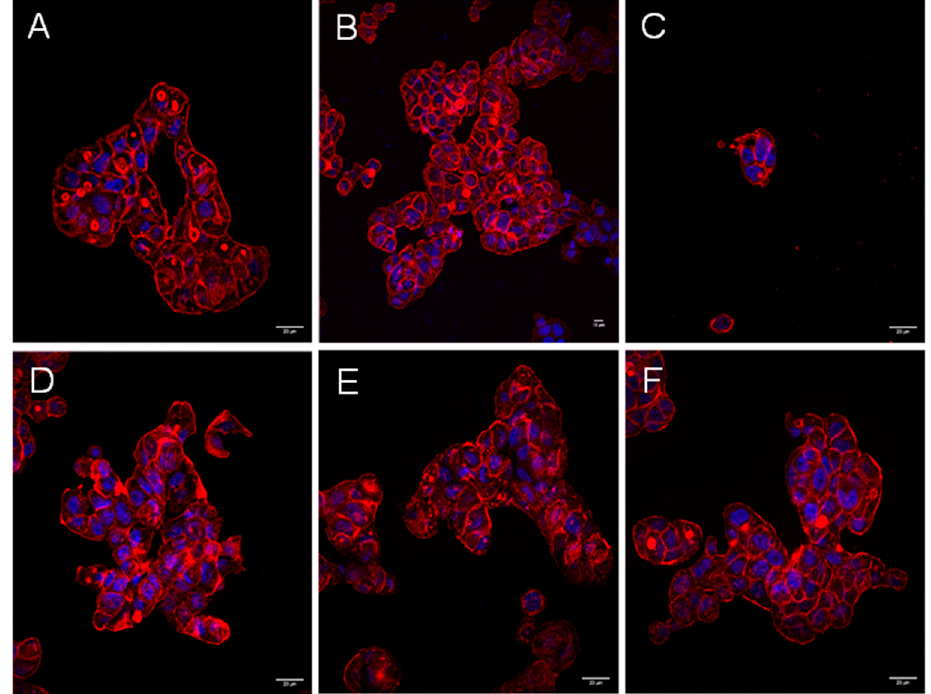
Figure 1. Aeromonas strains trigger a cytotoxic effect during the infection of HT-29 cells, but not the extracellular products they generate during their growth in the presence or absence of eukaryotic cells. Infection was carried out with non-cytotoxic strains LE20E ( A ), CI20E ( B ), and cytotoxic strain AG29E1 ( C ) for 90 and 180 min. Cells were fixed and stained for immunofluorescence. ( D – F ) Co-culture of Aeromonas strains (non-cytotoxic strain LE20E, cytotoxic strains CI21E, and AG29E1, respectively) with HT-29 cells in the inserts system. The actin cytoskeleton was labeled with Atto 594 phalloidin (red), and the nuclei stained with DAPI (blue). Results are representative of at least three independent experiments. Micrographs were originally captured at ×400 magnification. Bars indicate 20 µm.